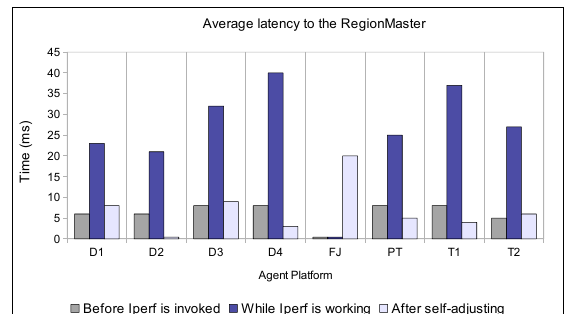
Figure 13. Average latencies to RegionMaster